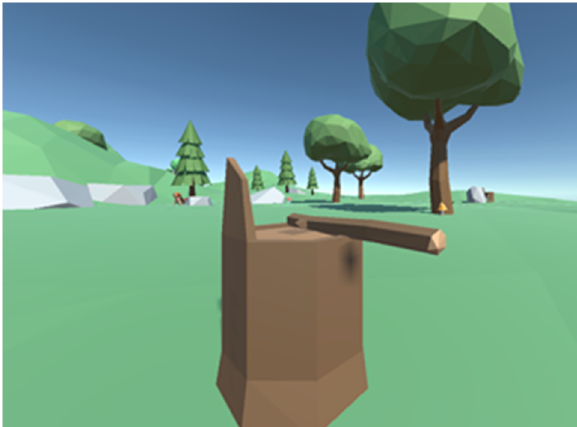
Figure 4. Content involving the use of wooden sticks to compare the feeling of using tools in the real world with that of virtual reality